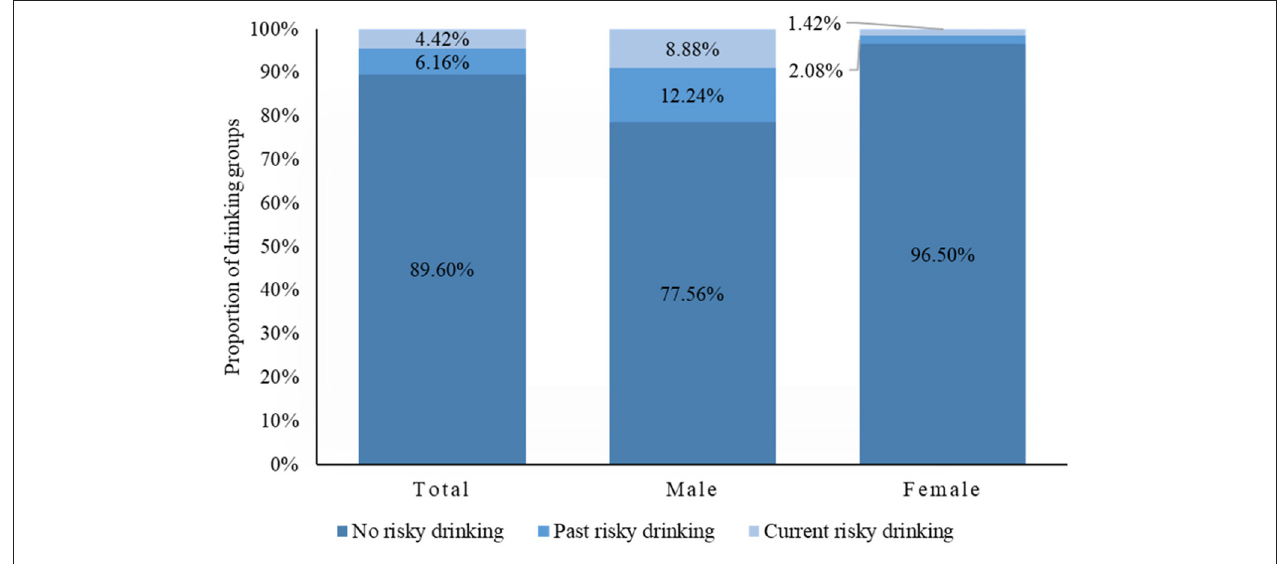
FIGURE 1 | Proportion of different risky drinking groups among whole sample and different genders.